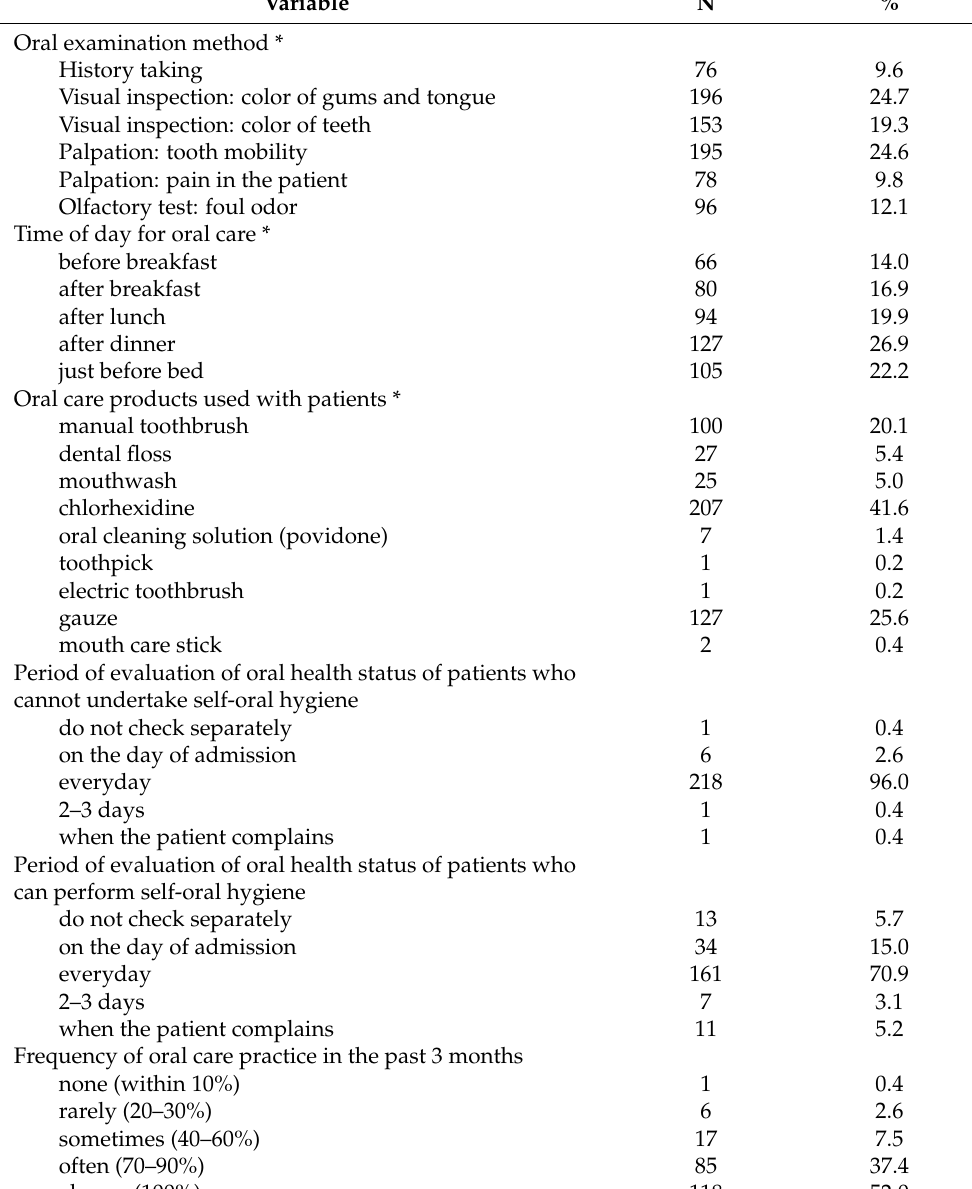
Table 2. ICU nurses’ practice of oral